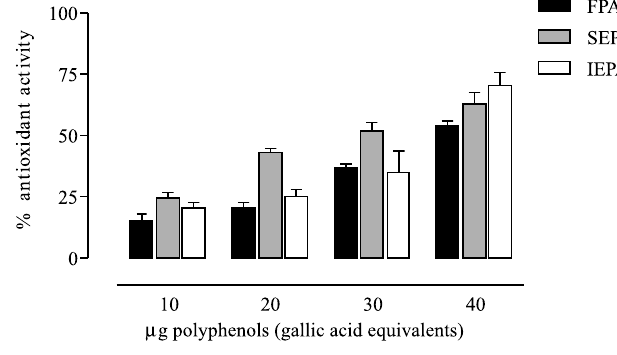
FIGURE 2 - DPPH • radical scavenging activity of polar fractions of Halimeda incrassata seaweed. The assay was performed as described by Goupy et al. , 1999. Results were given as % antioxidant activity and 50 % inhibitory concentration (IC Values represent mean ± s.d. (n=3).